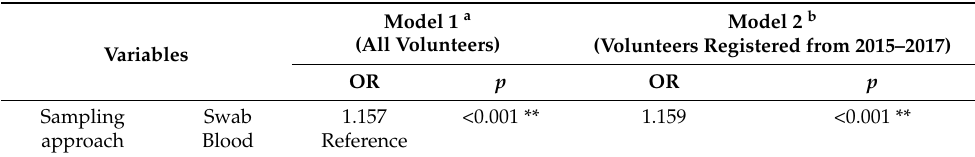
Table 2. Effect of sampling approach on volunteer Figure 3. HSCD volunteer retention rate by registration year.